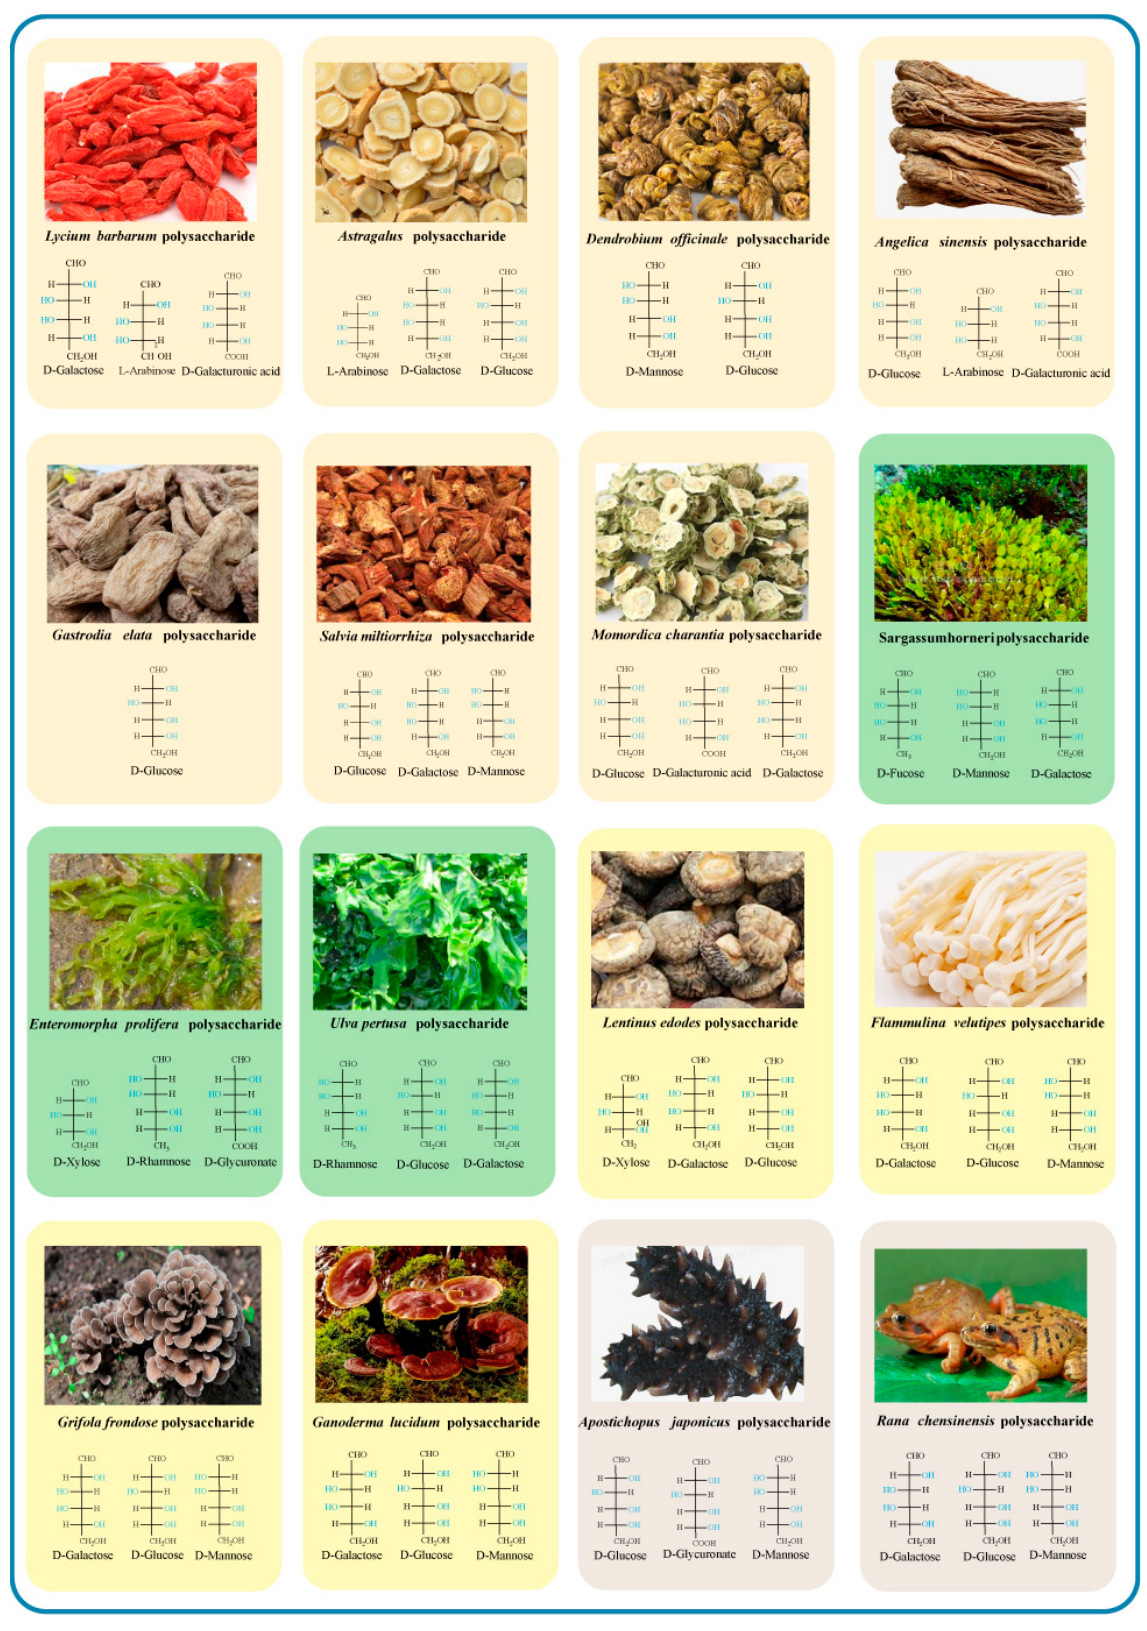
Figure 3. Sources and main monosaccharides of representative natural polysaccharides.